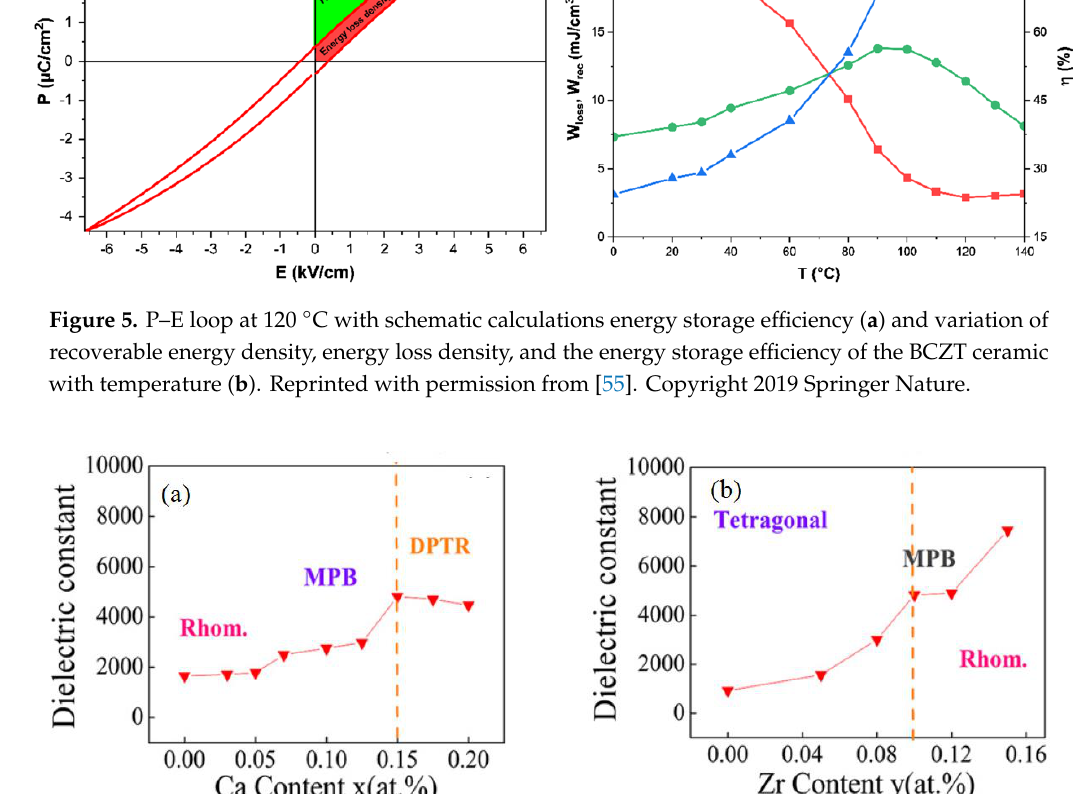
Figure 5. P – E loop at 120 °C with schematic calculations energy storage efficiency ( a ) and variation of recoverable energy density, energy loss density, and the energy storage efficiency of the BCZT ceramic with temperature ( b ). Reprinted with permission from [55]. Copyright 2019 Springer Nature.